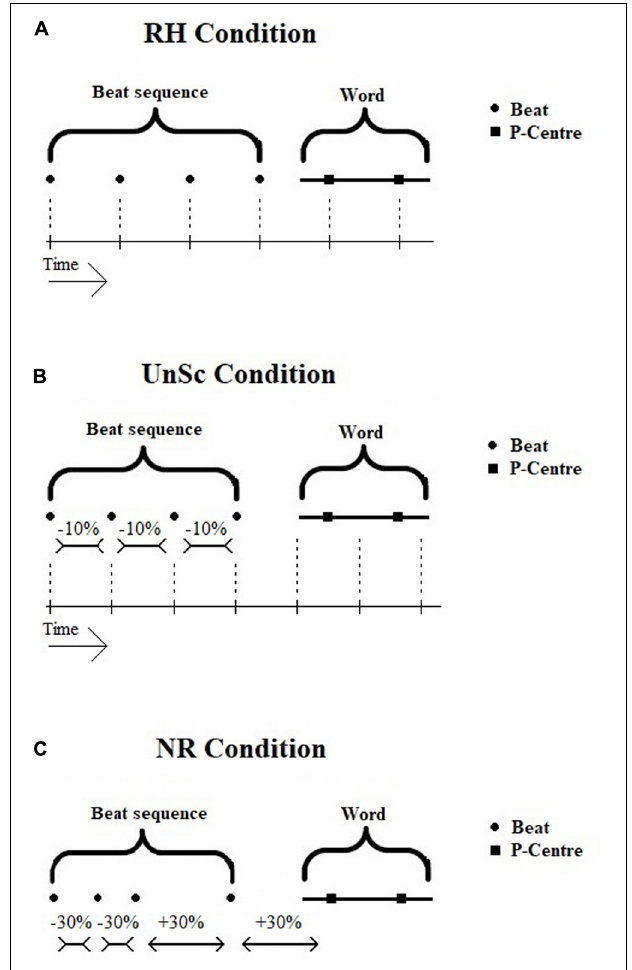
FIGURE 1 | (A–C) Visual display of WRRC condition stimuli, i.e., beat sequence and word. Noise is not displayed in the figure. (A) RH Condition. Beat sequence and word is synchronized, all intervals are equal. (B) UnSc Condition. Word is not synchronized with beat sequence by shortening IPIs by 10%. Not all interval are equal. (C) NR Condition. Beat sequence is not isochronous by shortening and lengthening IPIs by 30%, hence no rhythm